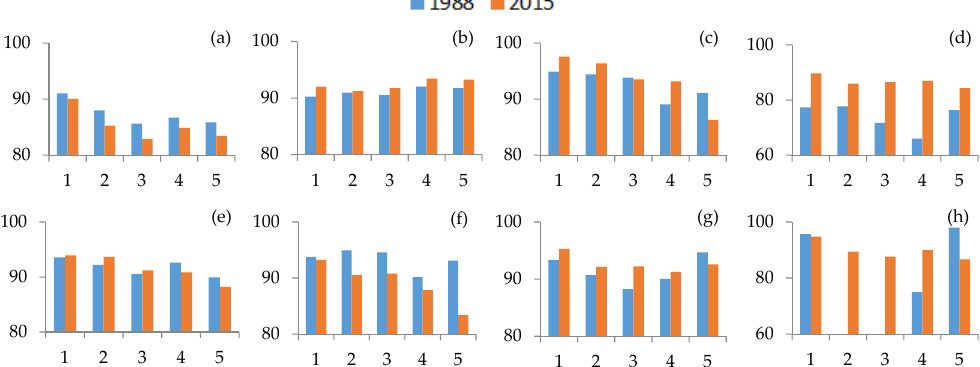
Figure 10. LSIs of the bays in 1988 and 2015. ( a ) Hai Loc Bay; ( b ) Dam Ha Trung Bay; ( c ) Danang Bay;